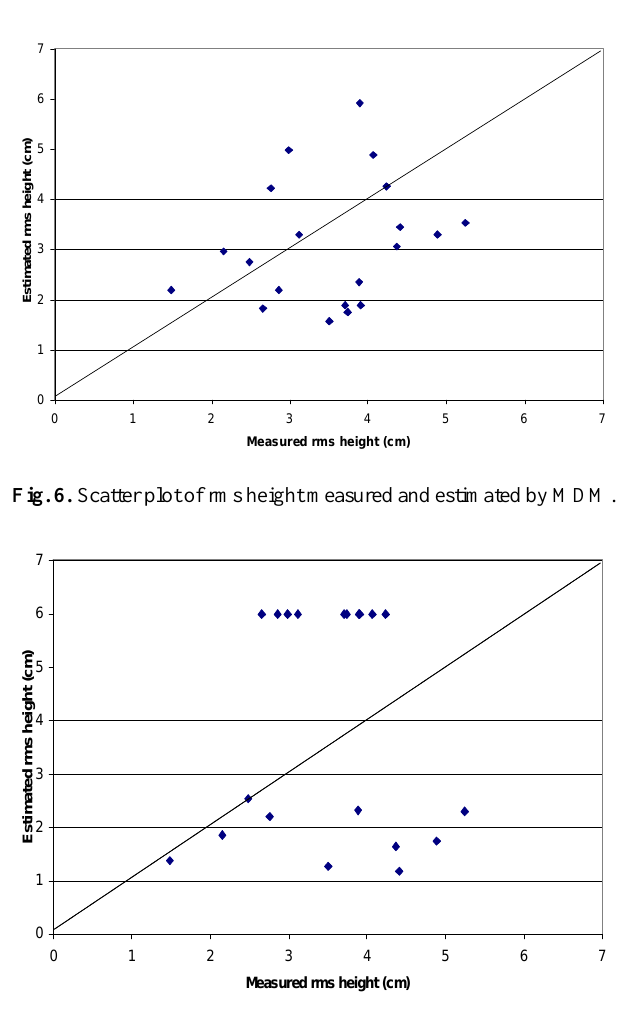
Fig. 7. Scatter plot of rms height measured and estimated by OM.